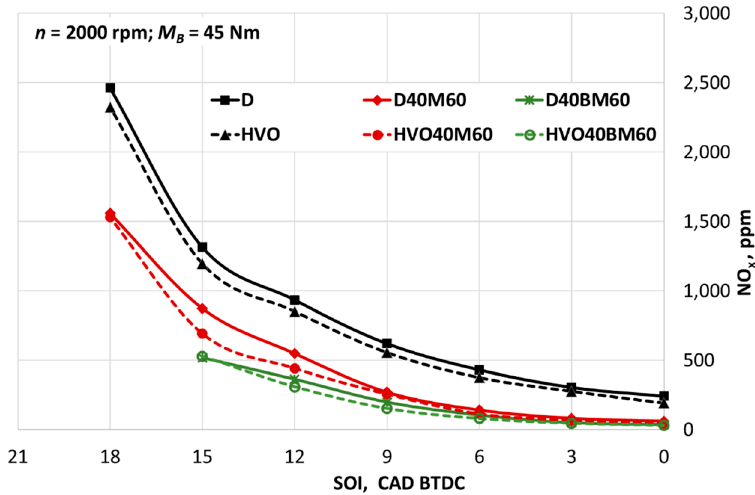
Figure 8. Change of NO x volumetric fraction depending on fuel composition and SOI.